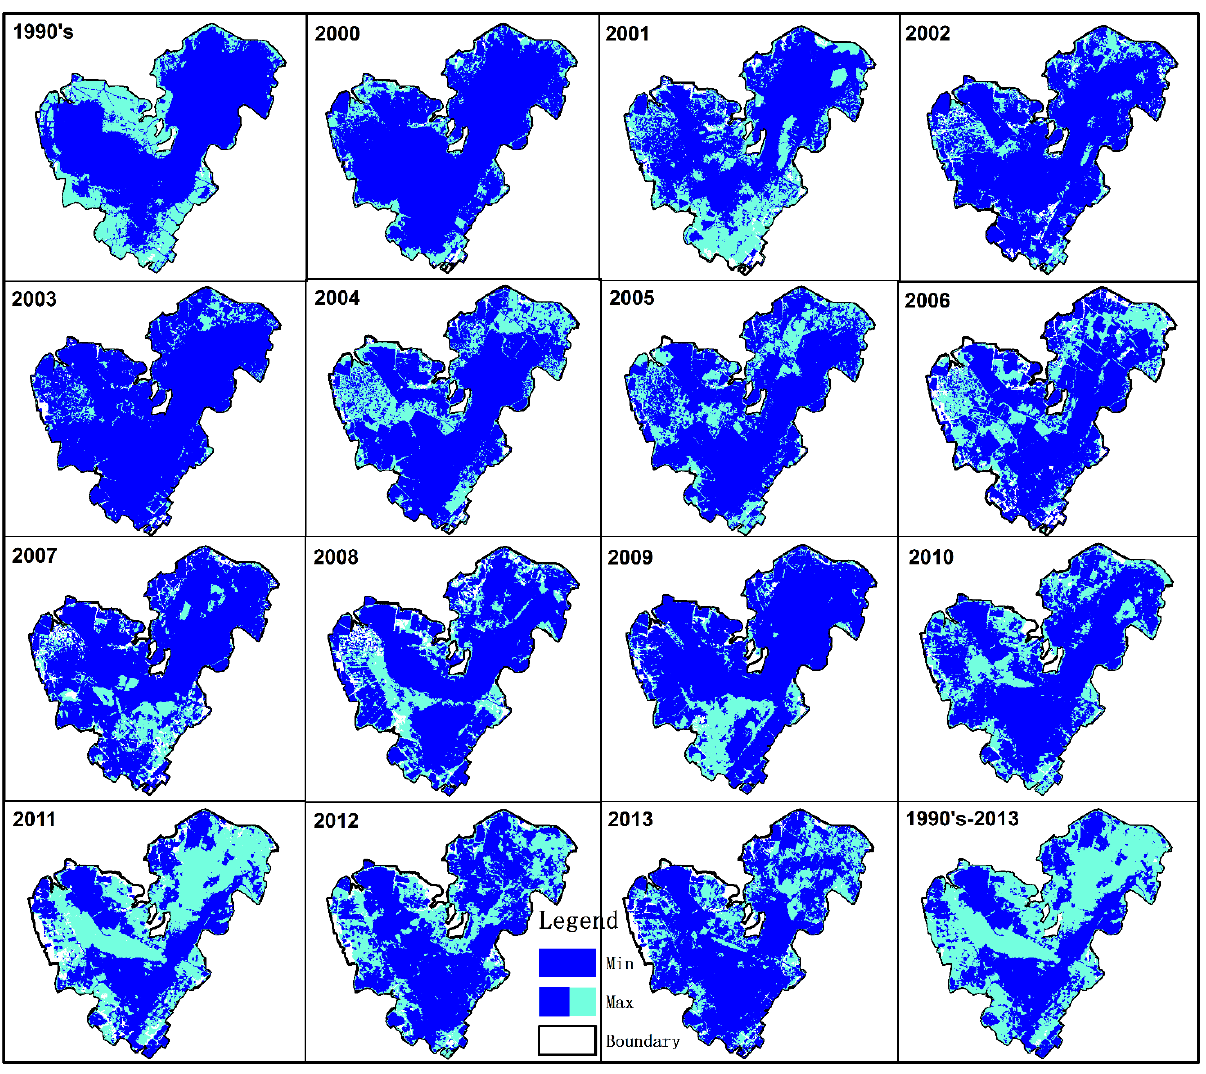
Figure 3. Minimum and maximum area distributions of Honghu Lake each year from 1990s to